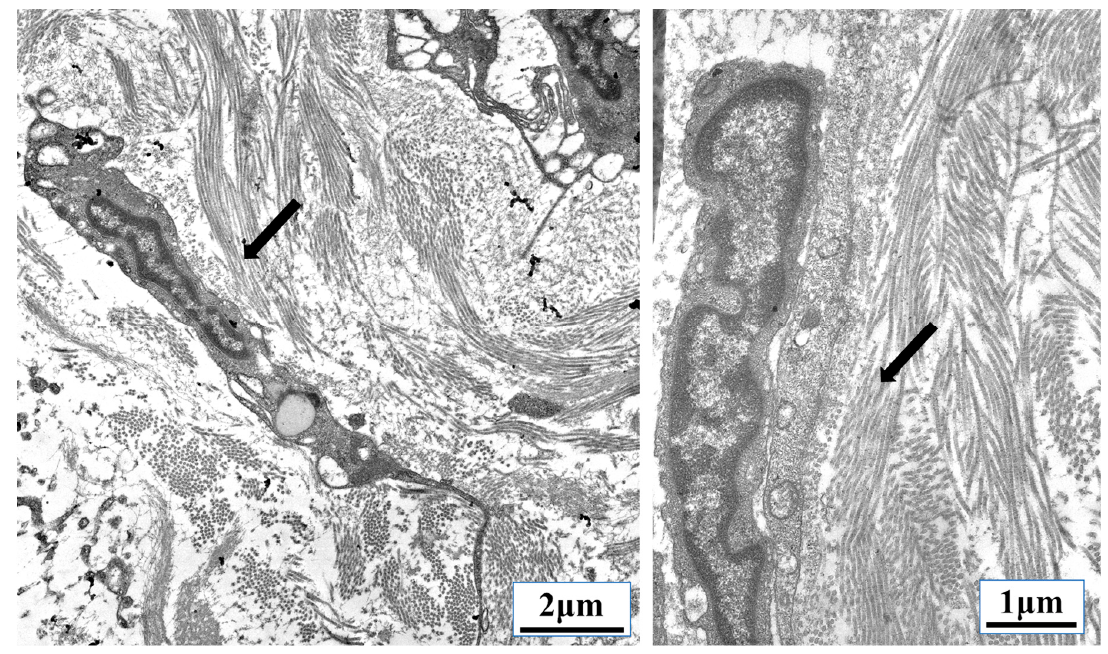
Figure 7. Parallel organization of extracellular matrix (ECM) fibrils can be used as migration tracts. Transforming growth factor β (TGF- β )-induced fibrosis and ECM remodeling during cancer transmits mechanical information from the tumor microenvironment directly to the nucleus of tumor cells, infiltrating leukocytes, fibroblasts, and endothelial cells. Some metastasizing cancer cells use parallel ECM fibrils, called “tumor-associated collagen signatures” (TACSs), similar to the collagen tracts (arrows) used by the leukocytes shown above migrating through lymphoid tissue. (Transmission electron microscopy images taken by our group.)